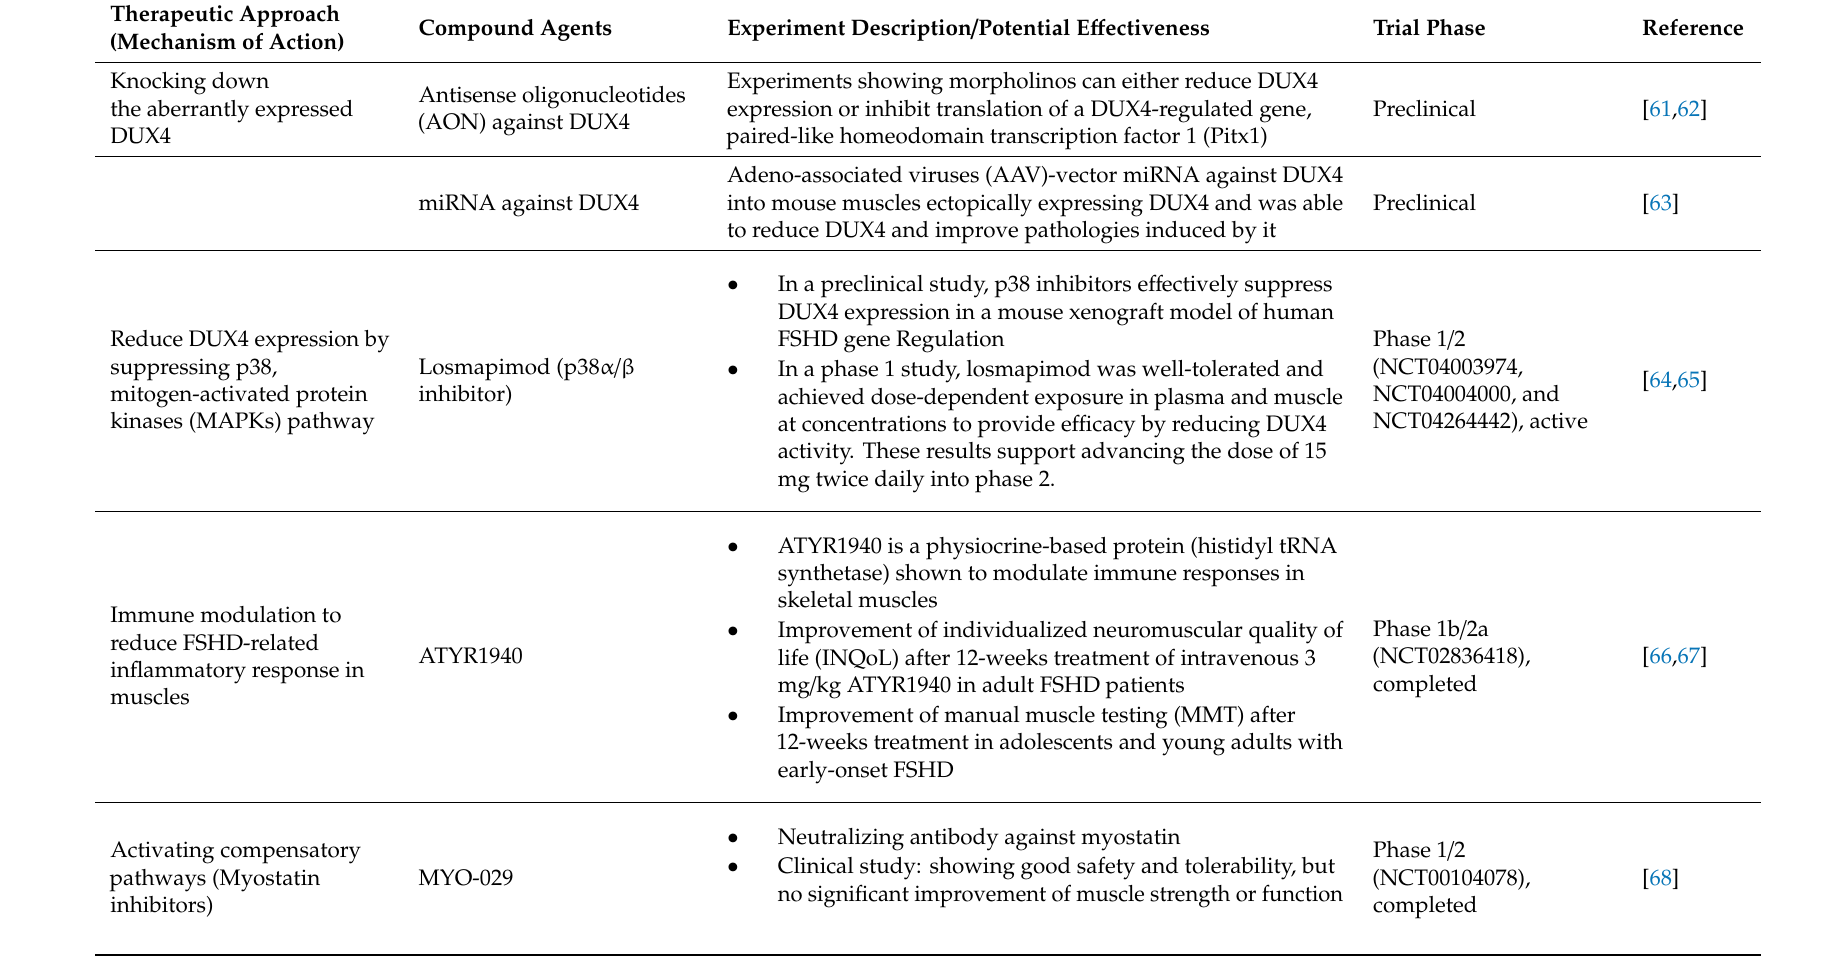
Table 2. Therapeutic approaches in facioscapulohumeral dystrophy: current clinical trials and preclinical